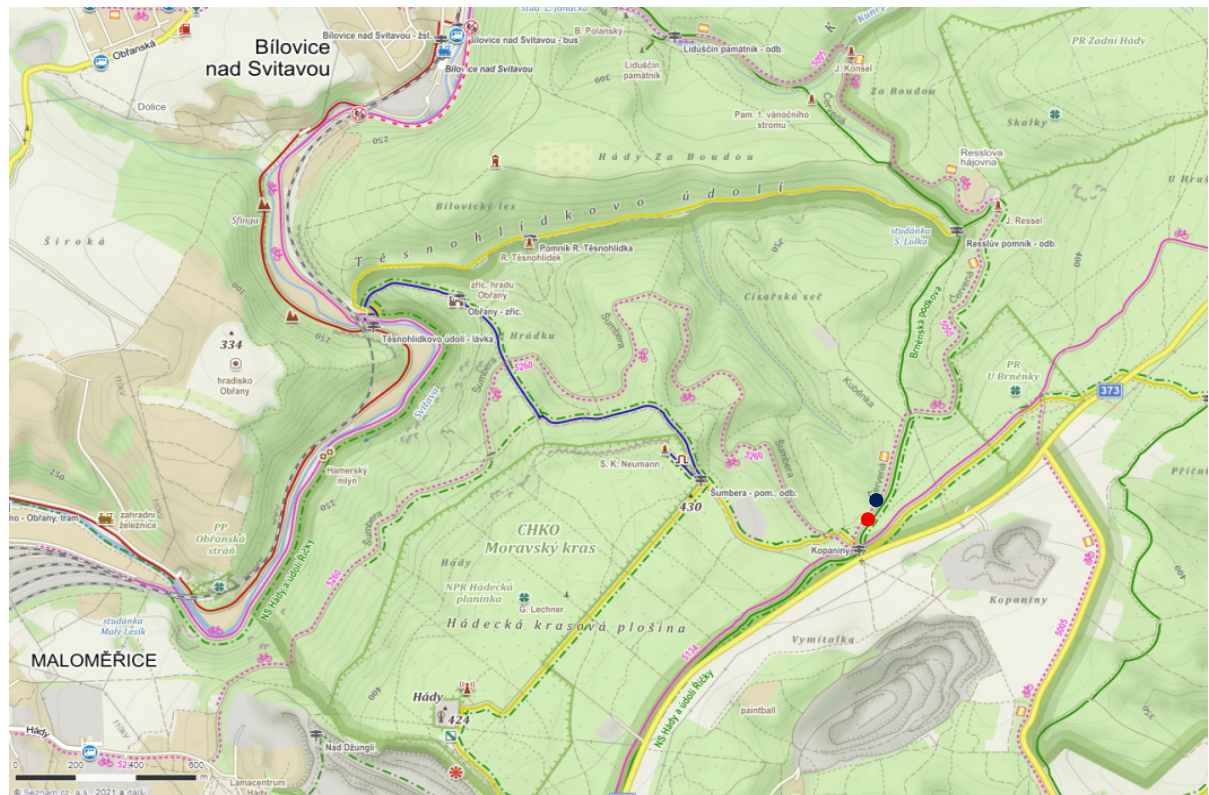
Figure 1. Evaluated part of Training Forest Enterprise (TFE) Masaryk Forest K ř tiny (Red dot on the forest road “ Č ervená” show the places of counters, forests are in green color [65].